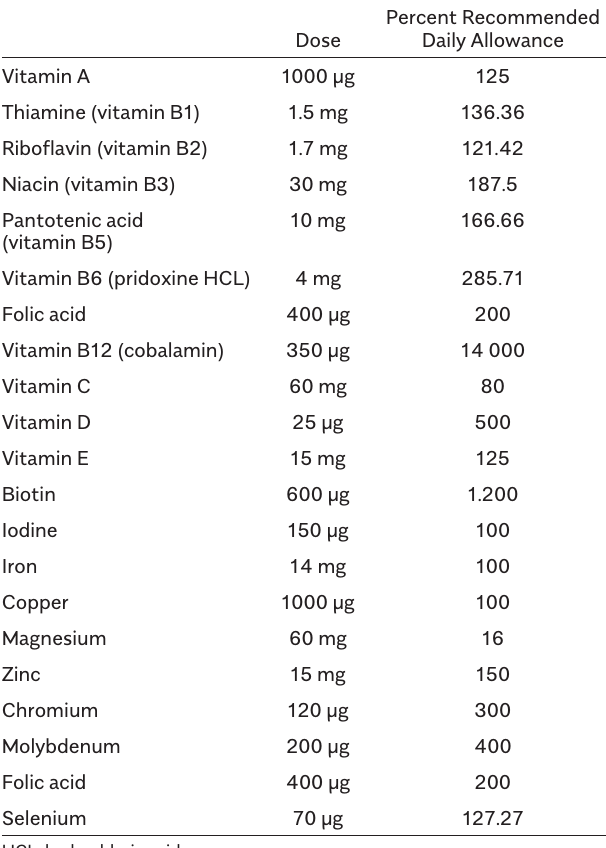
Table 1. Composition of the Multivitamin Supplement